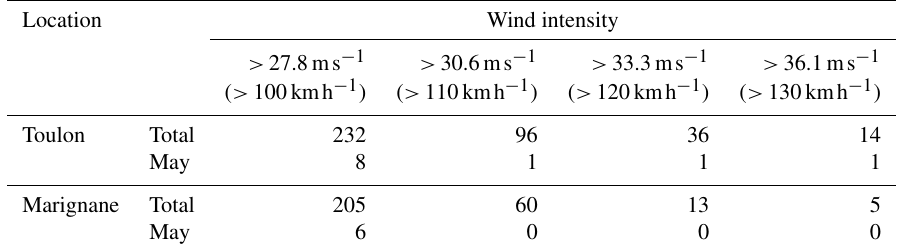
Table 3. The occurrence of different wind intensity events during the 1981–2010 period in the South of France for the entire (Total) period and for May only (http://tempetes.meteo.fr/spip.php?article221, last access: 5 January